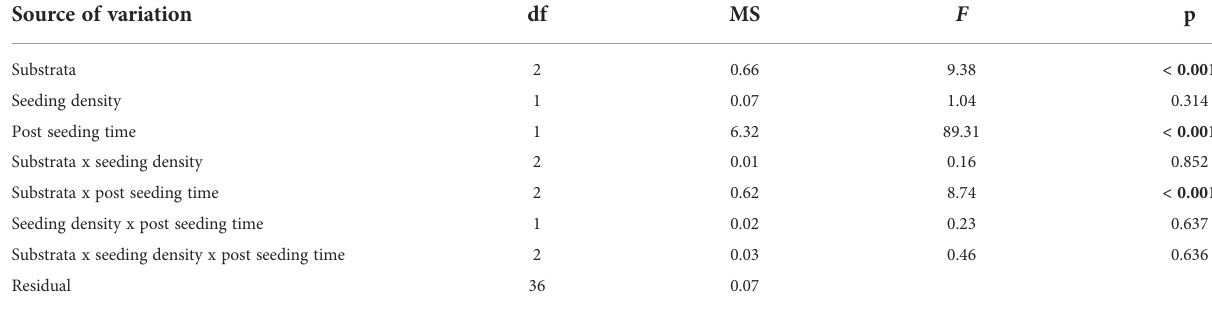
Signi fi cant results (p < 0.05) are highlighted in bold. Data were log10+1 transformed to meet the assumption of homogeneity of variances (before transformation p < 0.001; after transformation p =